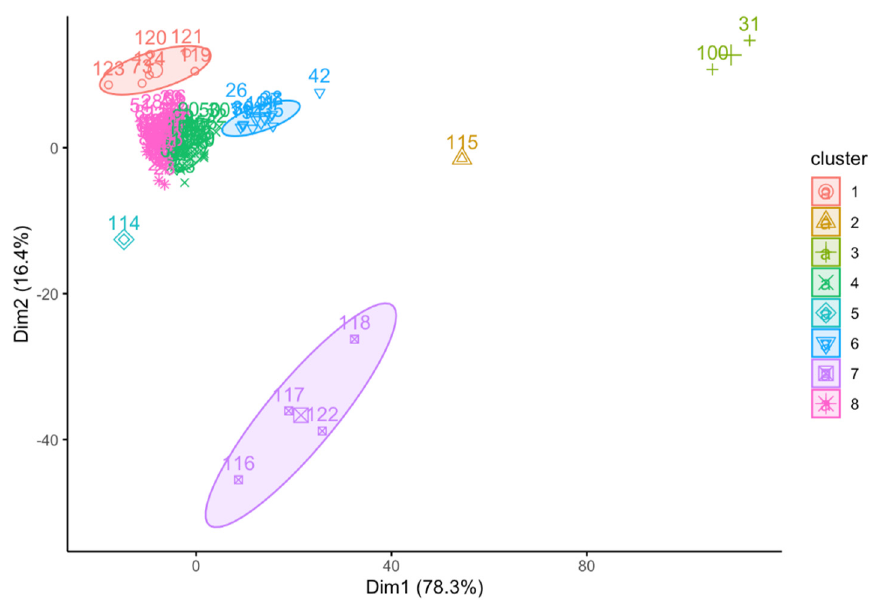
Figure 6. Principal component analysis of syrup adulterants and honey samples.